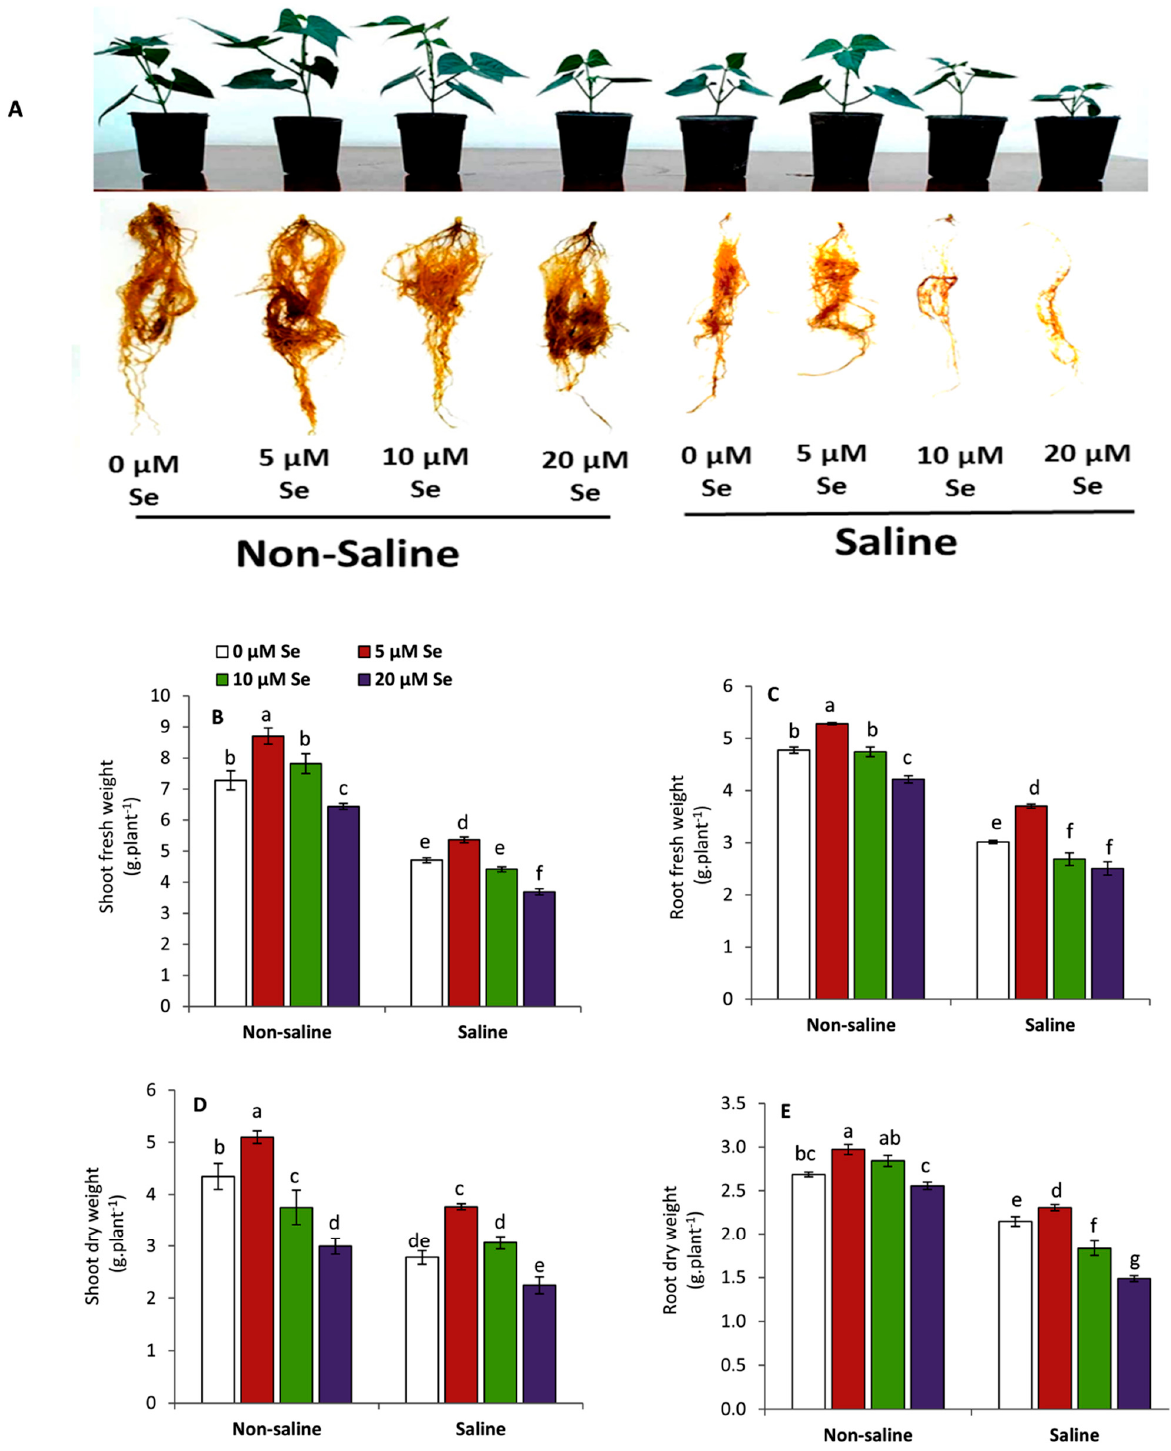
Figure 1. Effect of Se supplementation at 5, 10 and 20 µ M on growth performance ( A ), shoot fresh weight ( B ), shoot fresh weight ( C ), shoot dry weight ( D ) and root dry weight ( E ) of non-stressed and salt-stressed (50 mM NaCl) snap bean seedlings (28 days after sowing). The results are expressed as mean values of three measurements ± SE using Duncan’s multiple range test ( p = 0.05). Different letters indicate significant differences among the treatments.